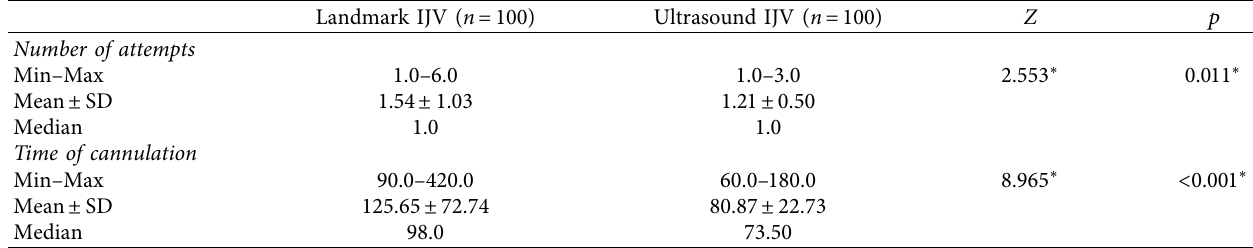
Table 2: Comparison between the landmark and ultrasound techniques in IJV group (A) according to the number of attempts and time of cannulation.